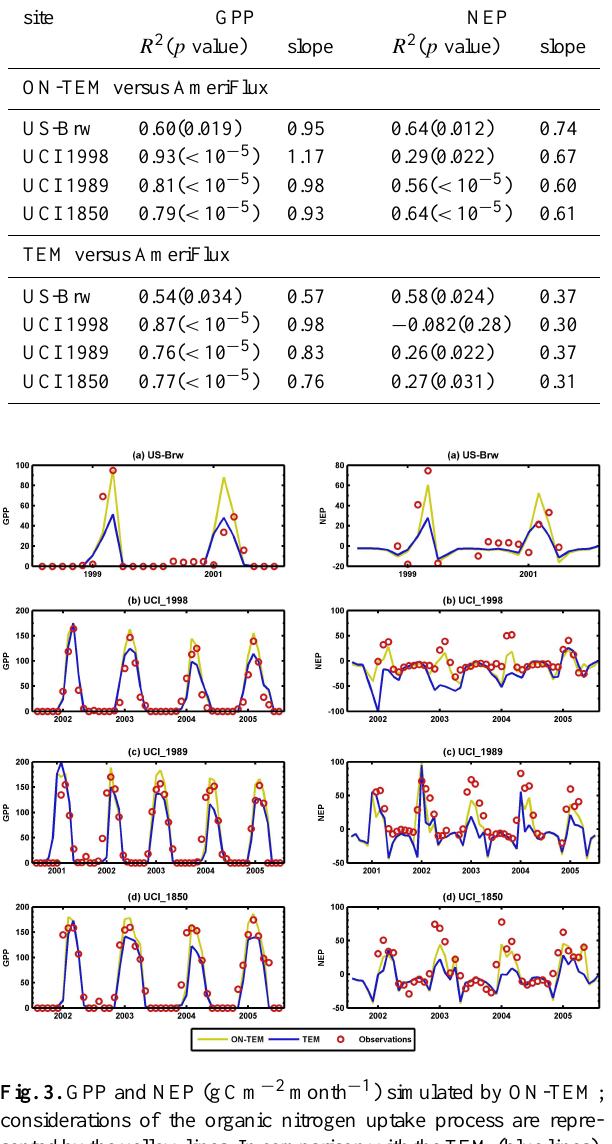
Table 5. Statistics interpretation for model–data fitting (in Fig. 3), which includes the linear regression slope, the Pearson correlation coefficient ( R 2 ) and the significance of the Pearson correlation co- efficient ( p value).